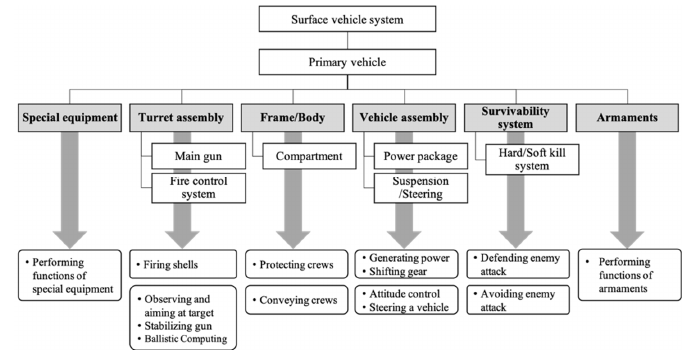
Figure 2. Hierarchical structure and inferred function of surface vehicle system.